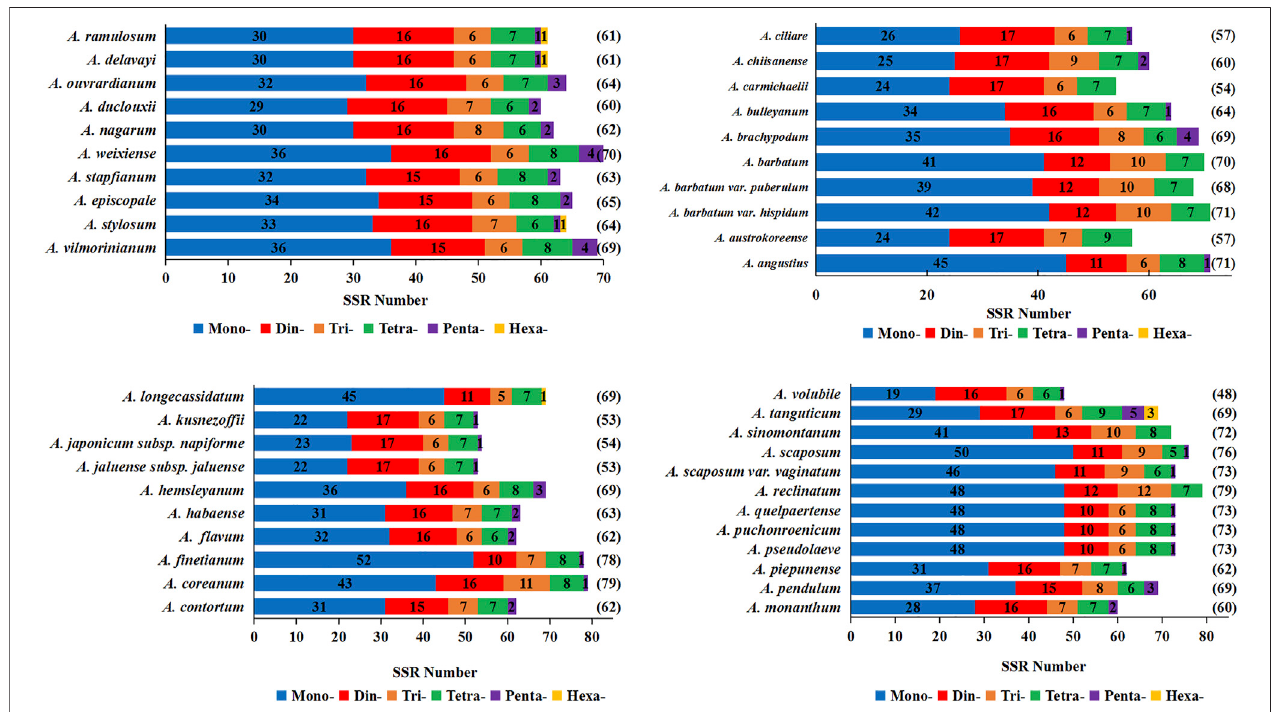
FIGURE 5 | Analysis of simple sequence repeat (SSR) in the chloroplast genomes of 42 Aconitum species.